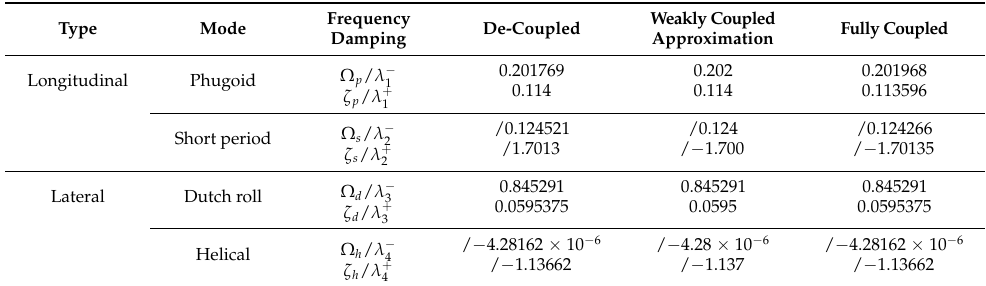
Table 5. Oscillation frequency and damping ratio of natural modes for case 1g in the Table